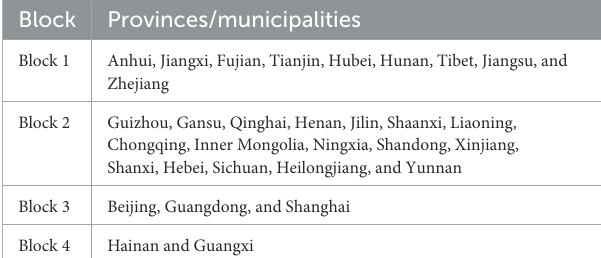
TABLE 7 Provinces/municipalities in each block of China’s low-carbon patent cooperation network in 2021. Block